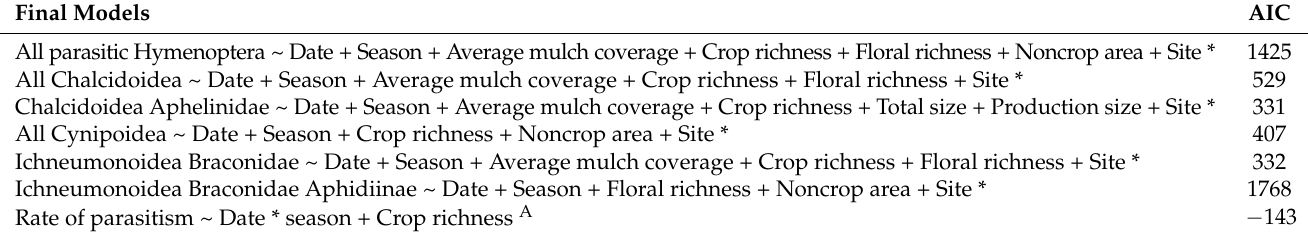
Table A2. Final GLMM Models.